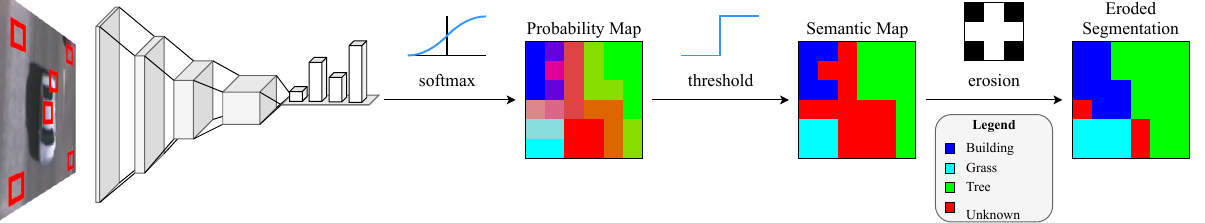
Figure 2. Simplified OpenPixel and Morph-OpenPixel architecture. The distinction between the networks is that OpenPixel does not contain the last morphological filtering step.